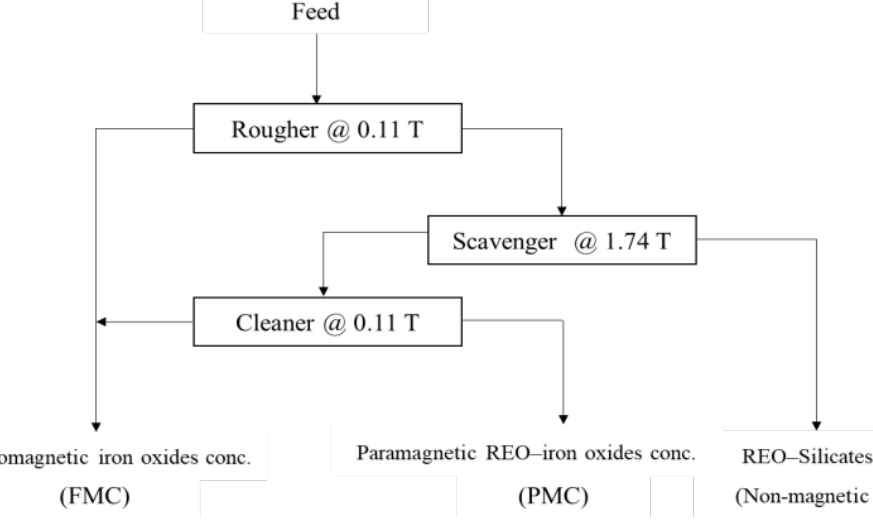
Figure 6. Flowsheet configuration using WHIMS to remove iron oxides prior to REE minerals upgrade [44].